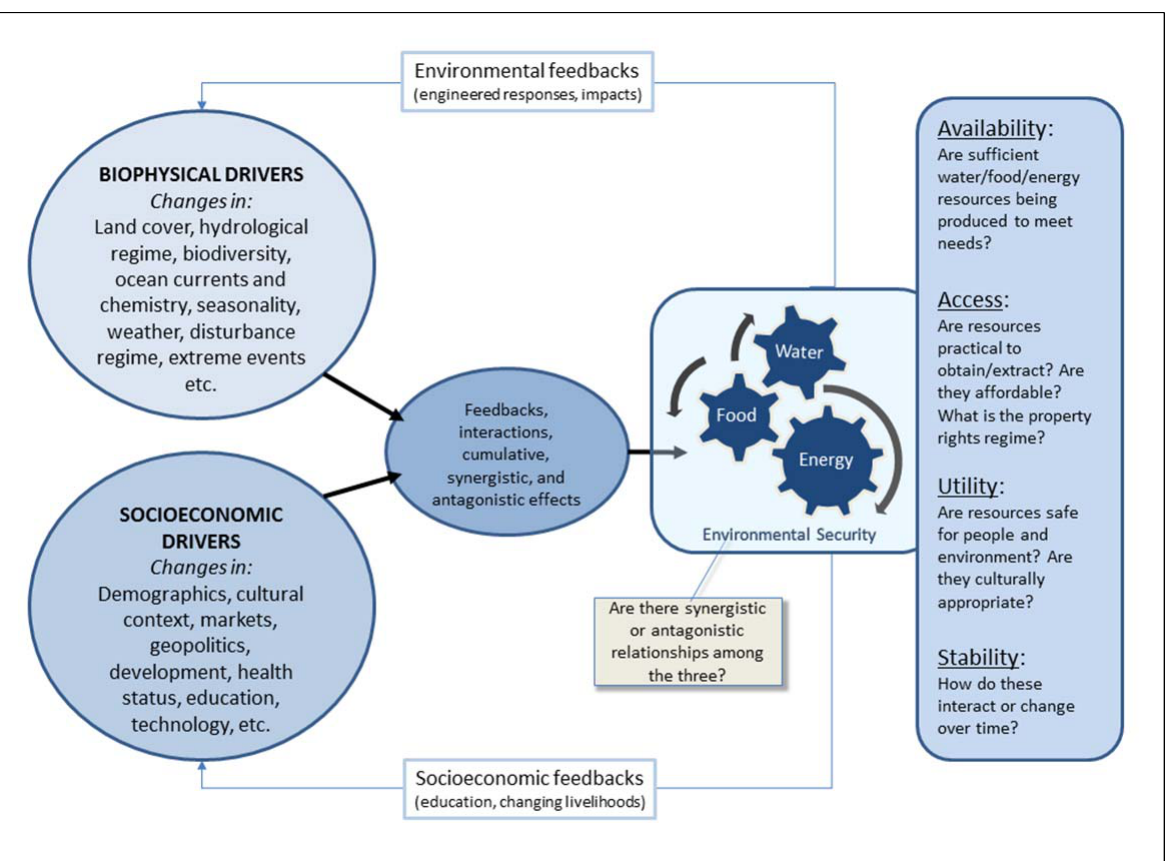
Figure 1. The New Environmental Security